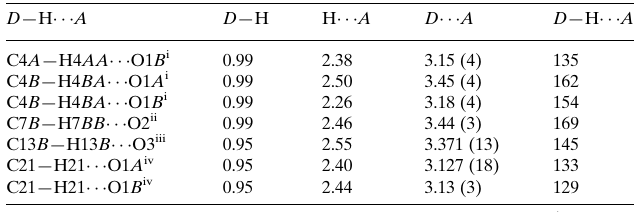
Hydrogen-bond geometry (A˚ , (cid:2)